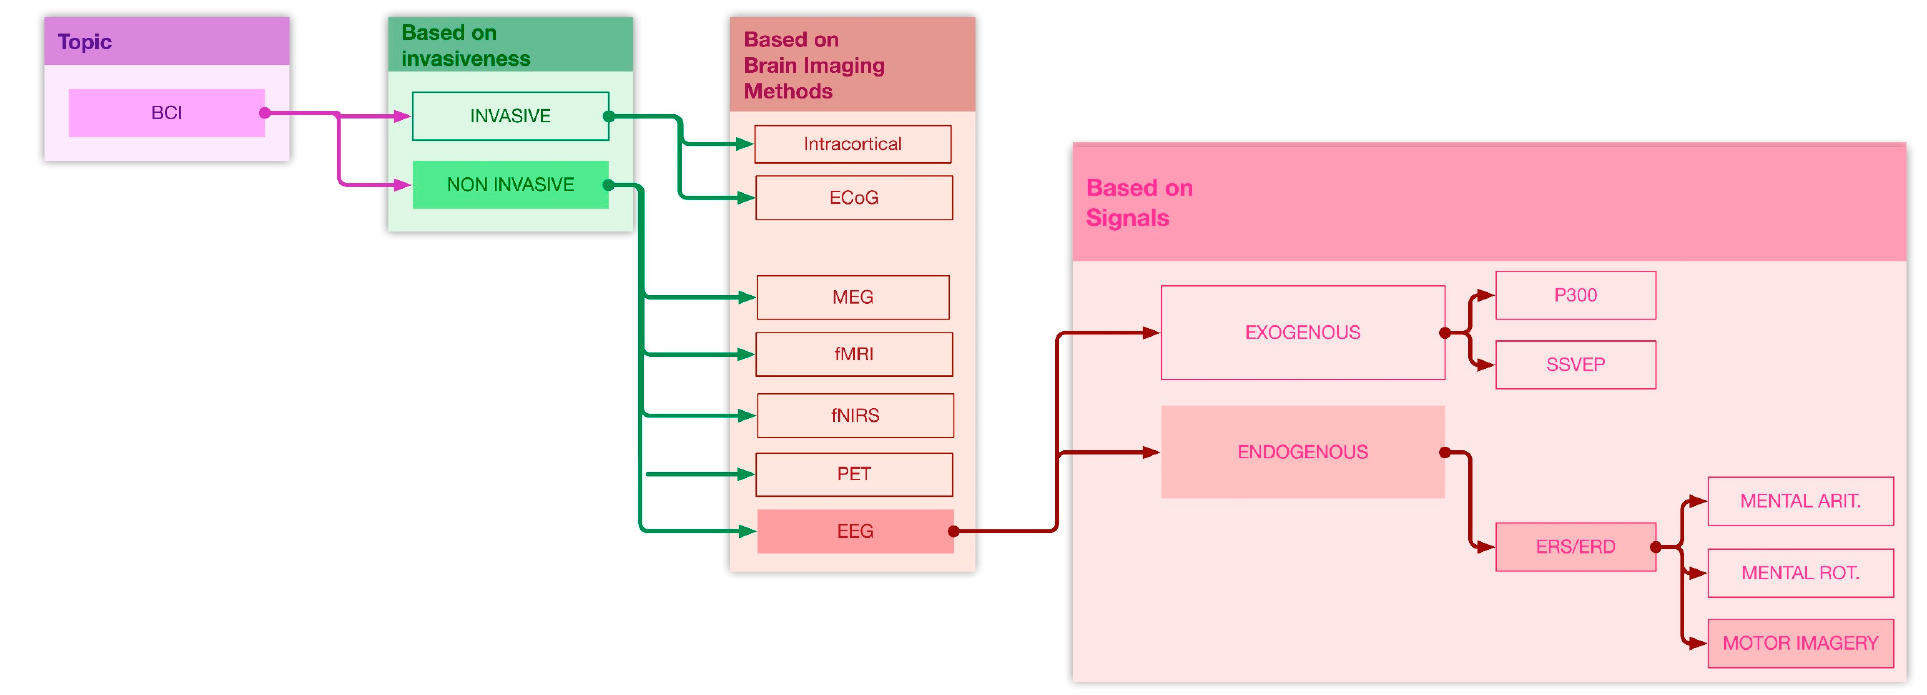
Figure 2. A synthetic overview of brain – computer Interface typologies and of biometric signals generally used in BCI systems. The path connecting the opaque colored blocks defines the sub-area of interest of the systematic review.